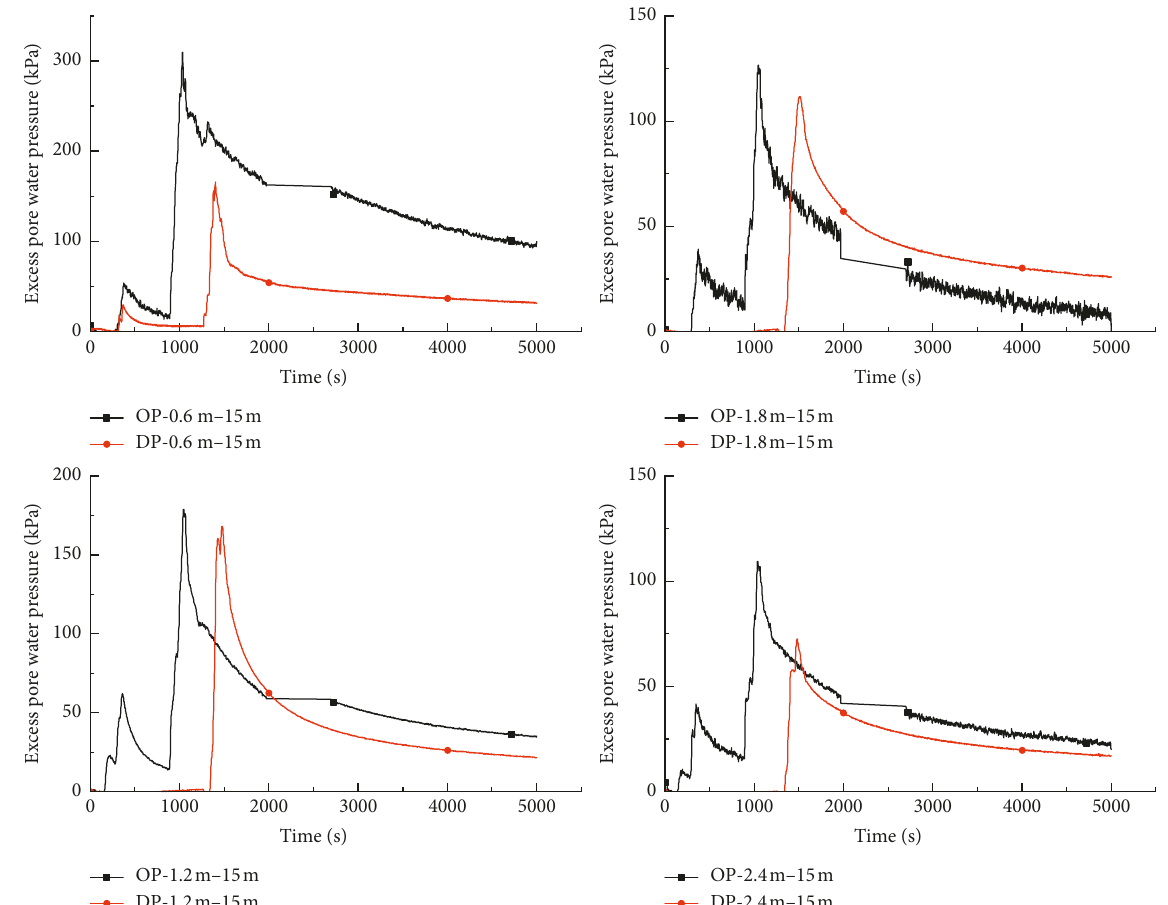
Figure 7: Dissipation curves of the excess pore water pressure (at 15 m